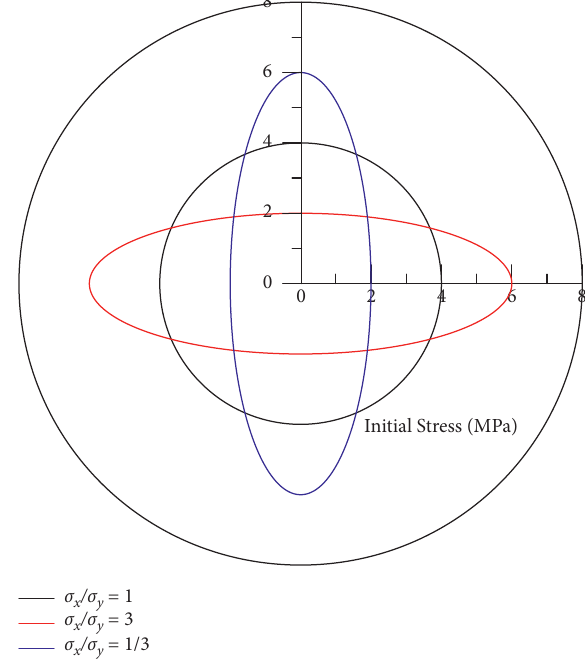
Figure 12: Initial stress